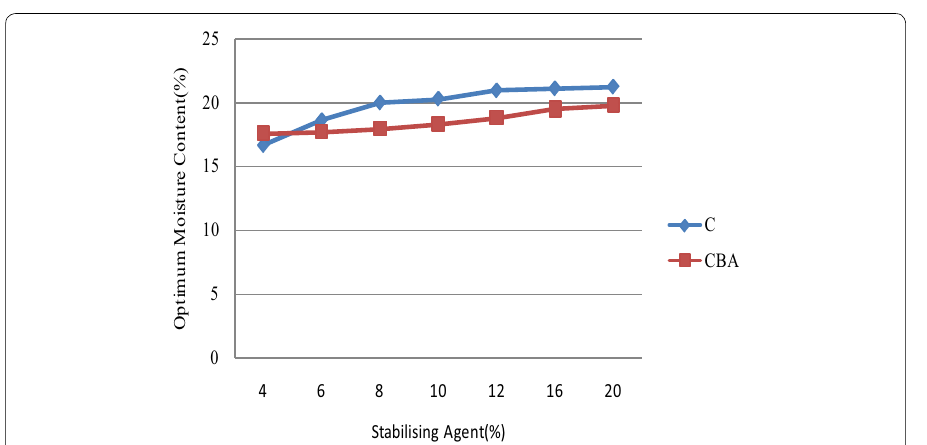
Fig. 6 Variation of OMC at different cement and cement–bottom ash